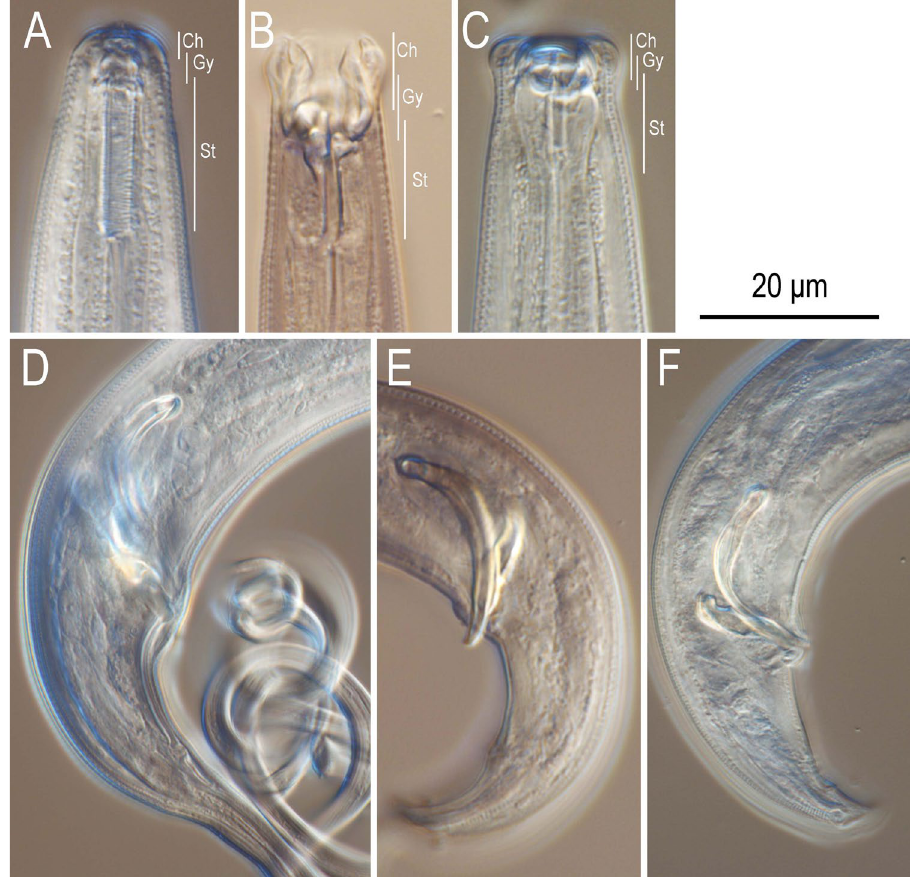
Figure 1. Anterior and male tail regions of three manatee-associated nematodes. ( A – C ) Stomatal region of Cutidiplogaster manati ( A ), “LT” ( B ) and “ST” ( C ); ( D – F ) Male tail region of Cutidiplogaster manati ( D ), “LT” ( E ) and “ST” ( F ). Cheilostom (Ch), Gymnostom (Gy) and Stegostom (St) are suggested with